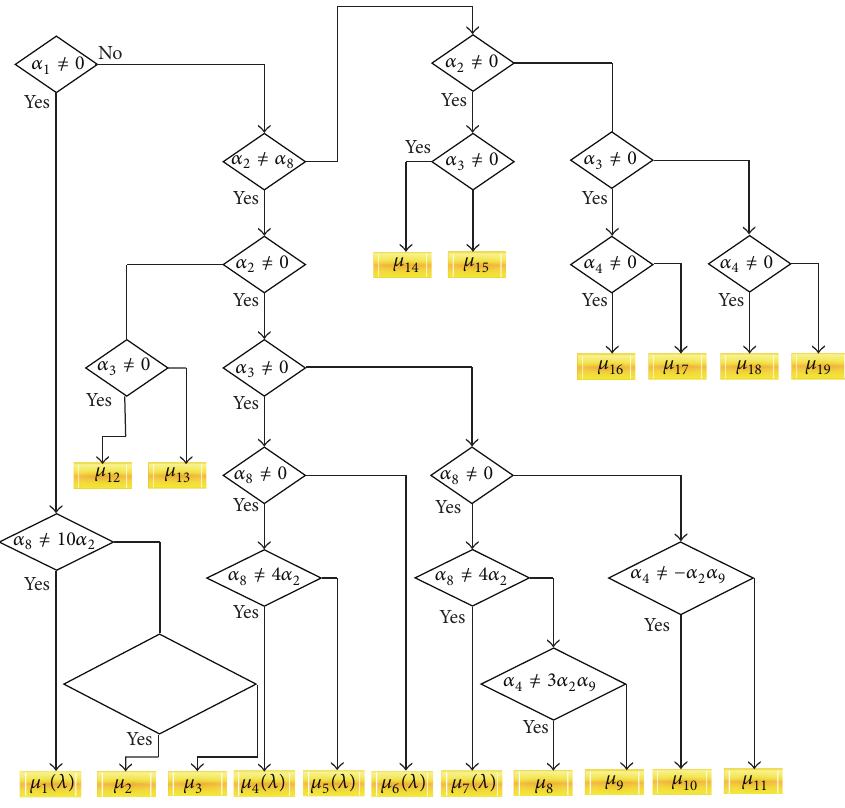
Figure 2: Case A: 𝛼 11 ̸=0 ; nonisomorphic subfamilies